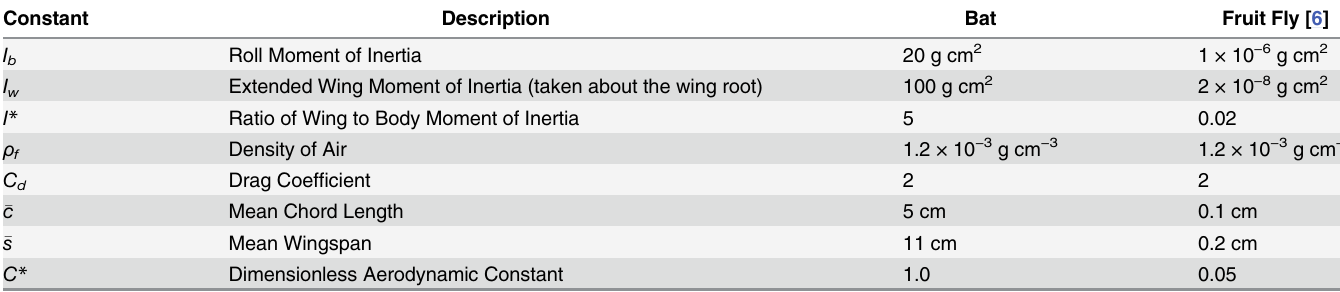
Dimensionless Aerodynamic